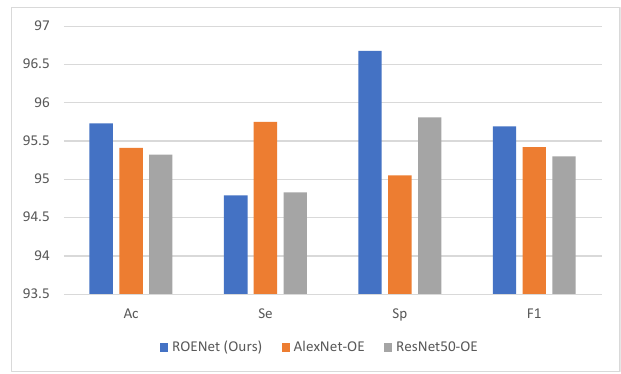
Figure 6. The comparison of different backbones.